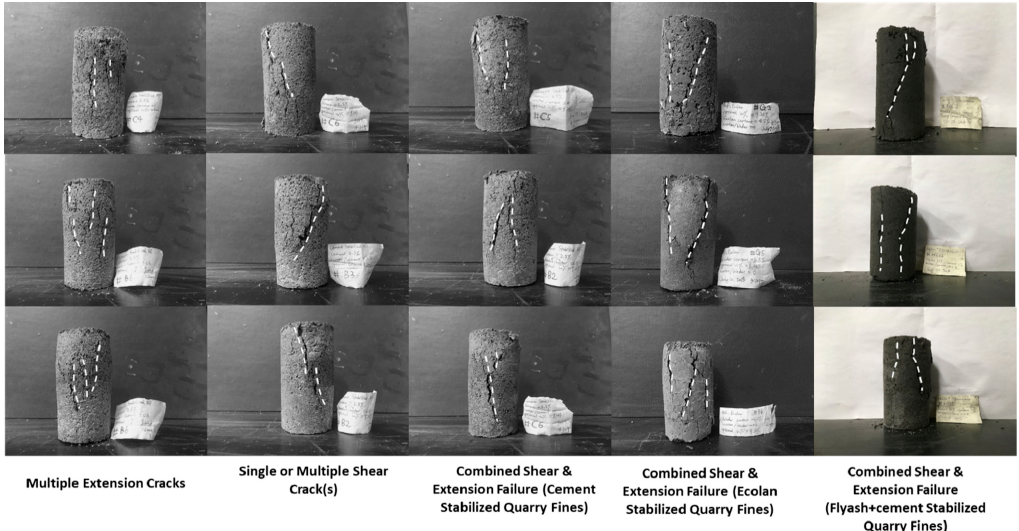
Figure 7. Cracking types (first two columns) and major failure mode (column three to five) of the stabilized quarry fine specimens in unconfined compressive test.